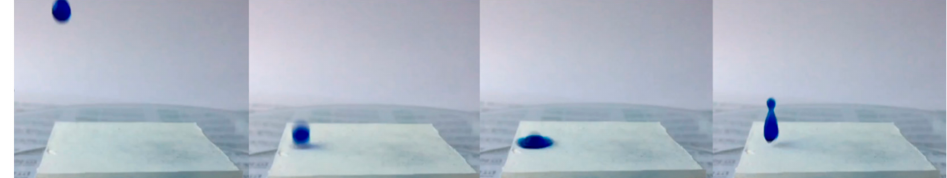
Figure 14. Time sequential images of the water droplet bounce on the fabricated superhydrophobic PP/SNPs